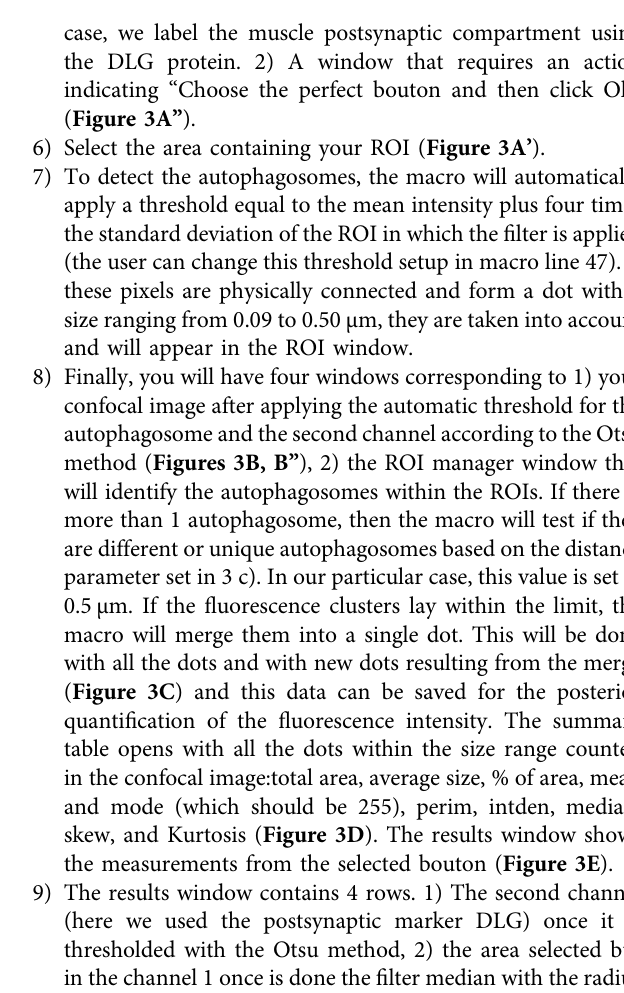
Frontiers in Cell and Developmental Biology |